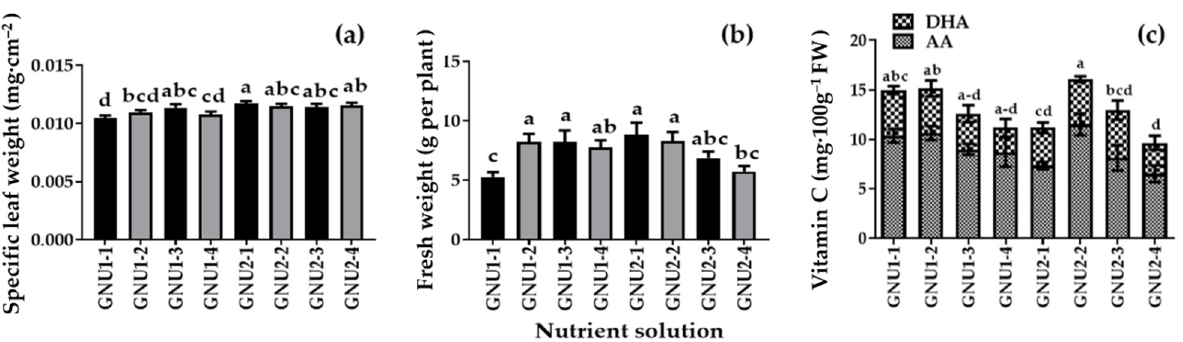
Figure 8. Specific leaf weight ( a ), fresh weight ( b ), and contents of ascorbic acid (AA) and L-dehydroascorbic acid (DHA) ( c ) of Ssamchoo as affected by the nutrient solutions 28 days after sowing in the experiment 2. The vertical bars represent the SEs of 30 biological replicates ( n = 30). Significant differences among treatments are indicated by lowercase letters at p ≤ 0.05 according to Duncan’s multiple range test.